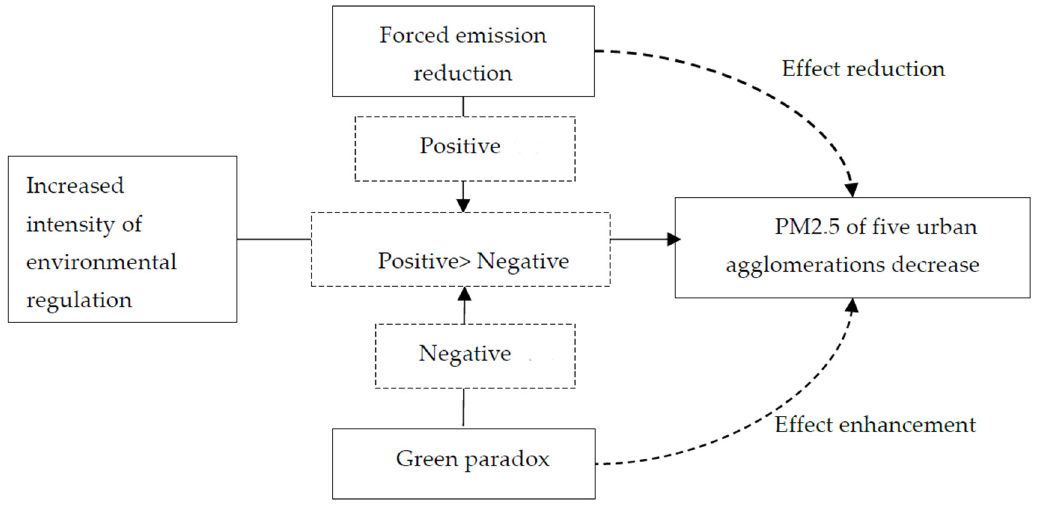
Figure 4. Effect of environmental regulation on haze in five urban agglomerations. What is the most suitable environmental regulation intensity for the five urban ag- glomerations? In this paper, we speculate based on the results of panel nonlinear model and threshold model. According to the panel nonlinear model, the impact of environ- mental regulation on haze concentration shows a “U” shape trend, and the threshold is 0.75 ( − GER = 11.64 ). That is, when the intensity of environmental regulation is less 2 × 7.743 − 2 × GER 2 than 0.75, the increase of environmental regulation can reduce the haze concentration. The positive “Forced emission reduction” is greater than the negative “Green paradox”. When the intensity of environmental regulation is greater than 0.75, the increase of environmental